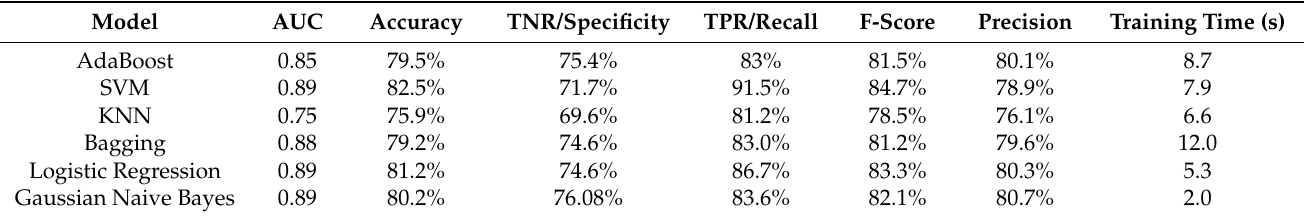
Table 5. Confusion matrix and the ROC curve values of various